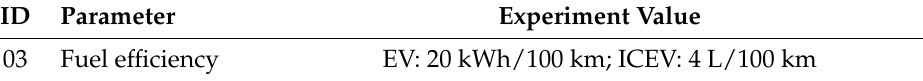
Table A3. Experiment